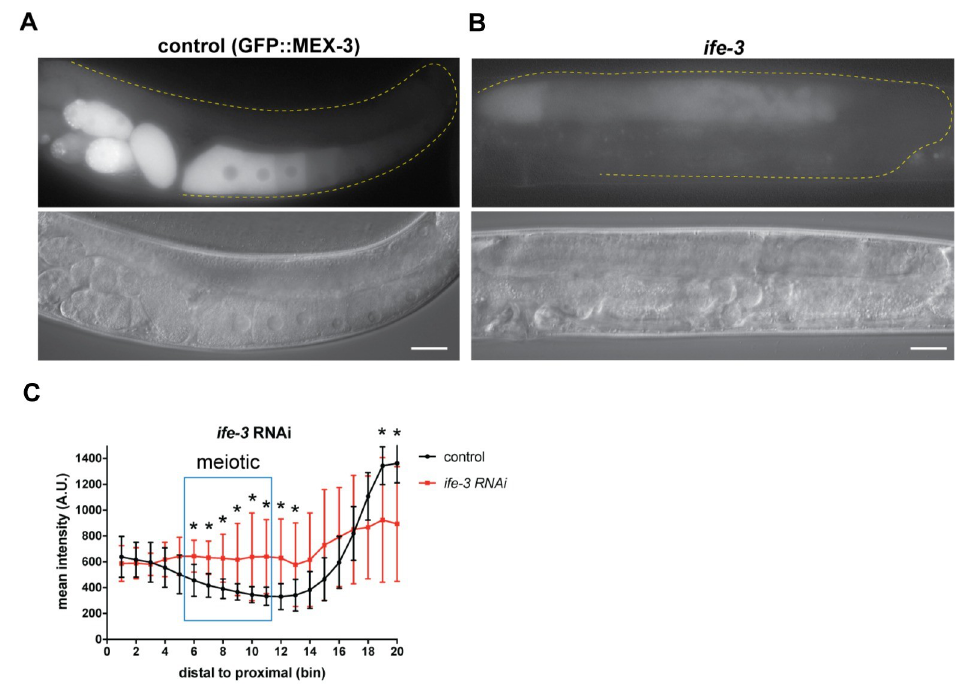
Fig 8. Translation initiation factor IFE-3 contributes to repression of MEX-3 in the meiotic pachytene region. (A) DIC and fluorescence images of wild type GFP::MEX-3 animals from the control RNAi. (B) DIC and fluorescence images after ife-3 knockdown. GFP::MEX-3 expression was significantly increased in the meiotic region. (C) quantitative analysis of fluorescence intensity after ife-3 knockdown (n = 13/13). ( � ) indicates statistical significance, adjusted p-value � 0.05. All p-values for this figure are reported in S7 Table. Scale bar = 30 μ